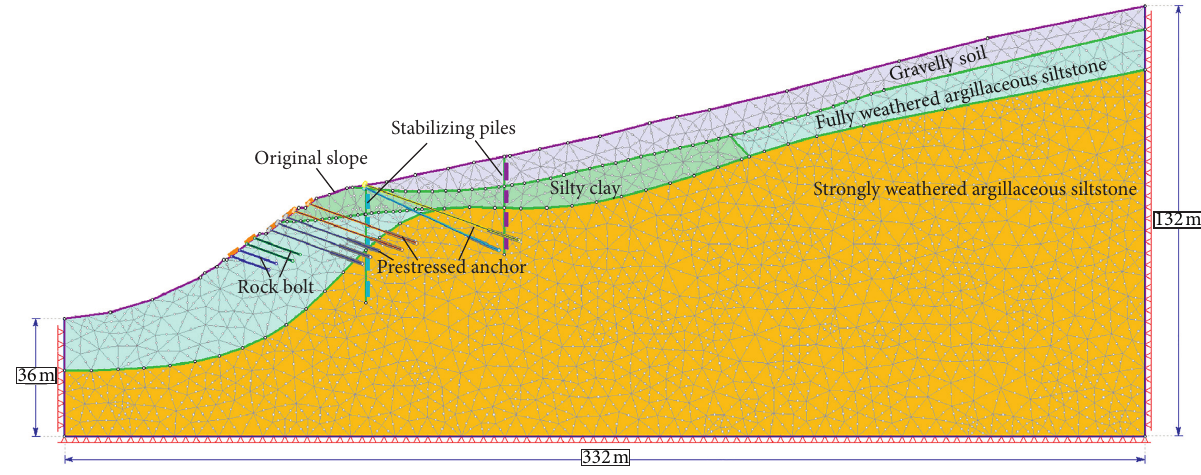
Figure 3: Finite element model for section 1-1.